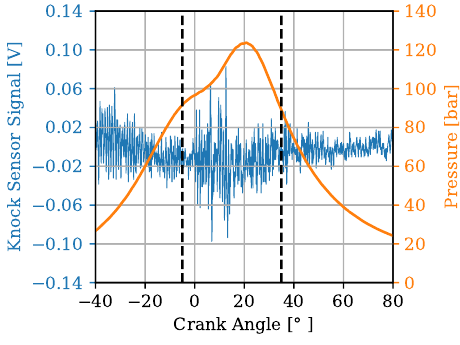
Figure 8. Window of cycle signals from − 5 to 35